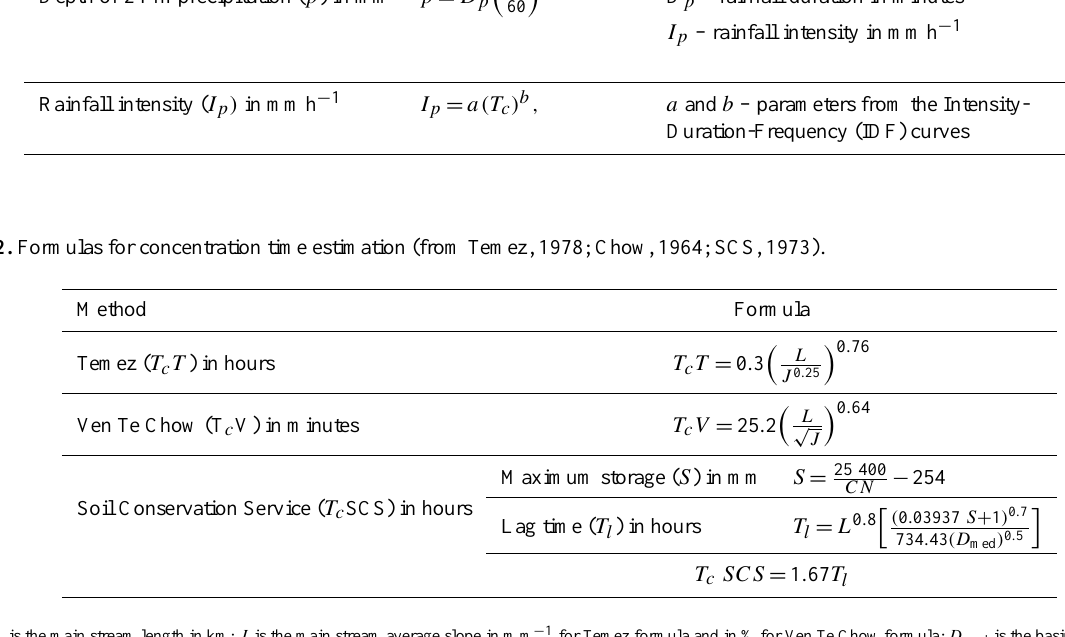
Table 1. Formulas for peak flow estimation using SCS method (from SCS, 1973). Peak discharge ( Q p ) in m 3 s − 1 Q p = RA Depth of runoff (R) in mm p – depth of 24-hr precipitation (mm) Maximum storage ( S ) in mm S = 25 400 Depth of 24-hr precipitation ( p ) in mm p = D p